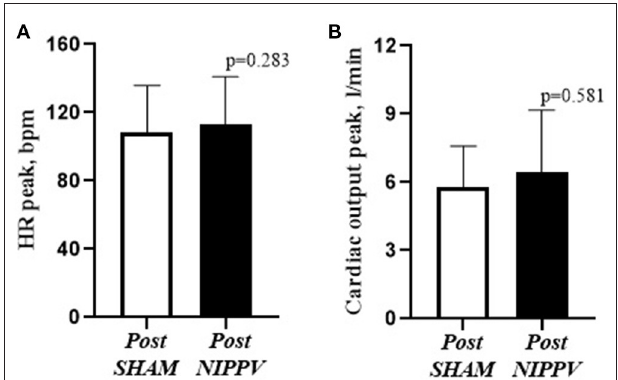
FIGURE 3 | Comparison between HR and cardiac output during ventilation and NIPPV. Heart rate (HR); non-invasive positive pressure ventilation (NIPPV); (A) HR peak. (B) cardiac output. Student’s t